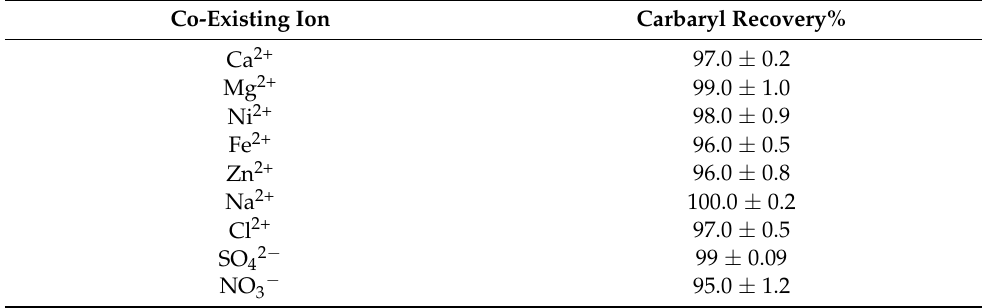
Table 1. The recovery of carbaryl from water in the presence of coexisting ions ( n = 3).